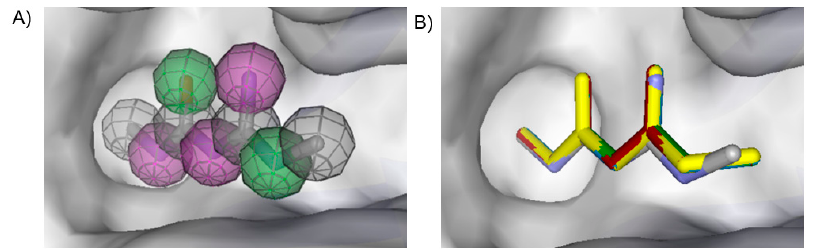
Figure 2. ( A ) Ligand template set up for docking; spheres indicate hydrogen acceptor (green), hy- drogen donors (purple) and steric (gray). ( B ) Dimethylguanylurea (DGU) conformer reproducibility of four independent runs in the AfChiB1 active